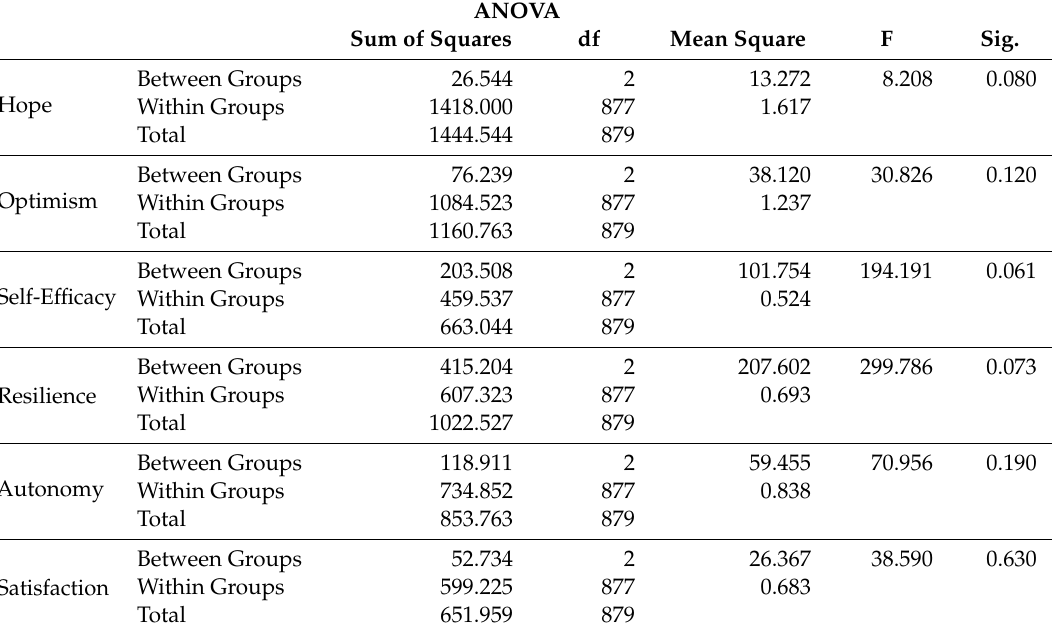
Table 4. Results of ANOVA test of di ff erence of variables between male and female. ANOVA Sum of Squares df Mean Square F